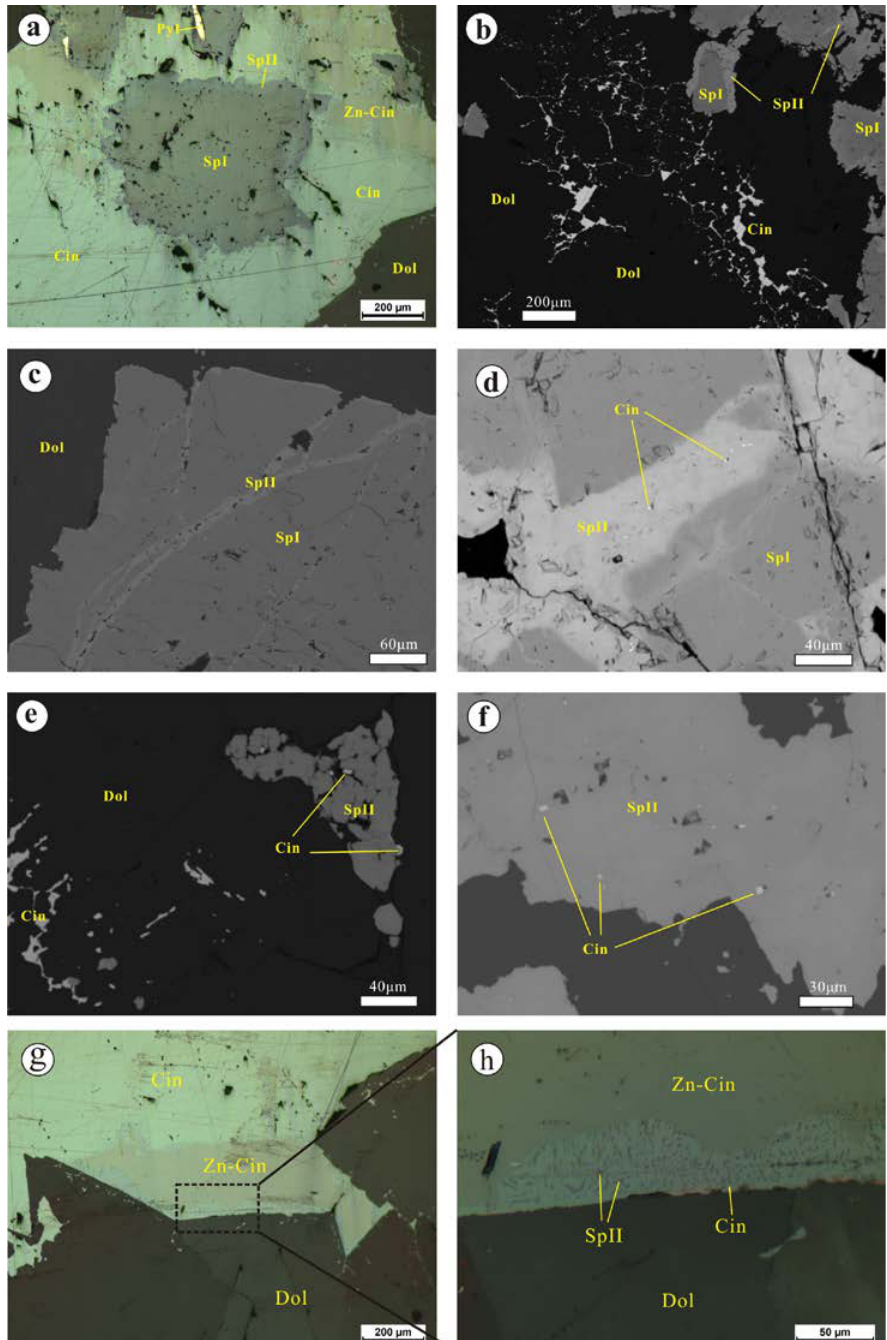
Figure 4. Photomicrographs ( a , g , h ) and backscattered electron images ( c – f ) of sphalerite II (SpII). ( a ) enlargement of Figure 3c with sphalerite II forming a rim around the sphalerite I (SpI), sphalerite I included in cinnabar (Cin), and zinc-bearing cinnabar (Zn-Cin) also replaced by cinnabar; ( b ) sphalerite II replace sphalerite I, and cinnabar forming interstitial network in dolomite; ( c ) sphalerite II replace sphalerite I along the surface and fractures of sphalerite I; ( d ) sphalerite II replace sphalerite I in fracture, and cinnabar present in Hg-bearing sphalerite; ( e ) sphalerite II grains with cinnabar filling dolomite (Dol); ( f ) cinnabar inclusions in sphalerite II; ( g ) Zn-bearing cinnabar (Zn-Cin) replaced by cinnabar (Cin), with vermicular sphalerite II in cinnabar located at replacement boundary; and ( h ) detailed view of Figure 4g, showing vermicular sphalerite II intergrowth in cinnabar.